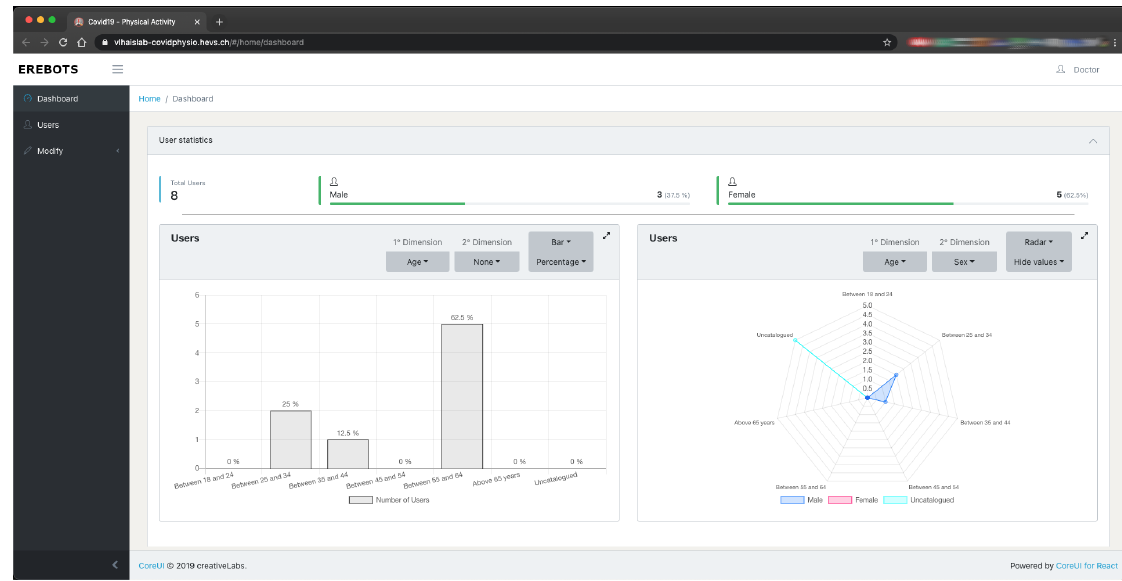
Figure 6. EREBOTS dashboard for healthcare personnel displaying the campaign in multidimensional graphs. Concerning UF1, at the first access, the user is required to register a profile on Pryv.io and grant access to the specified information (see Figure 7). In this way, the user has